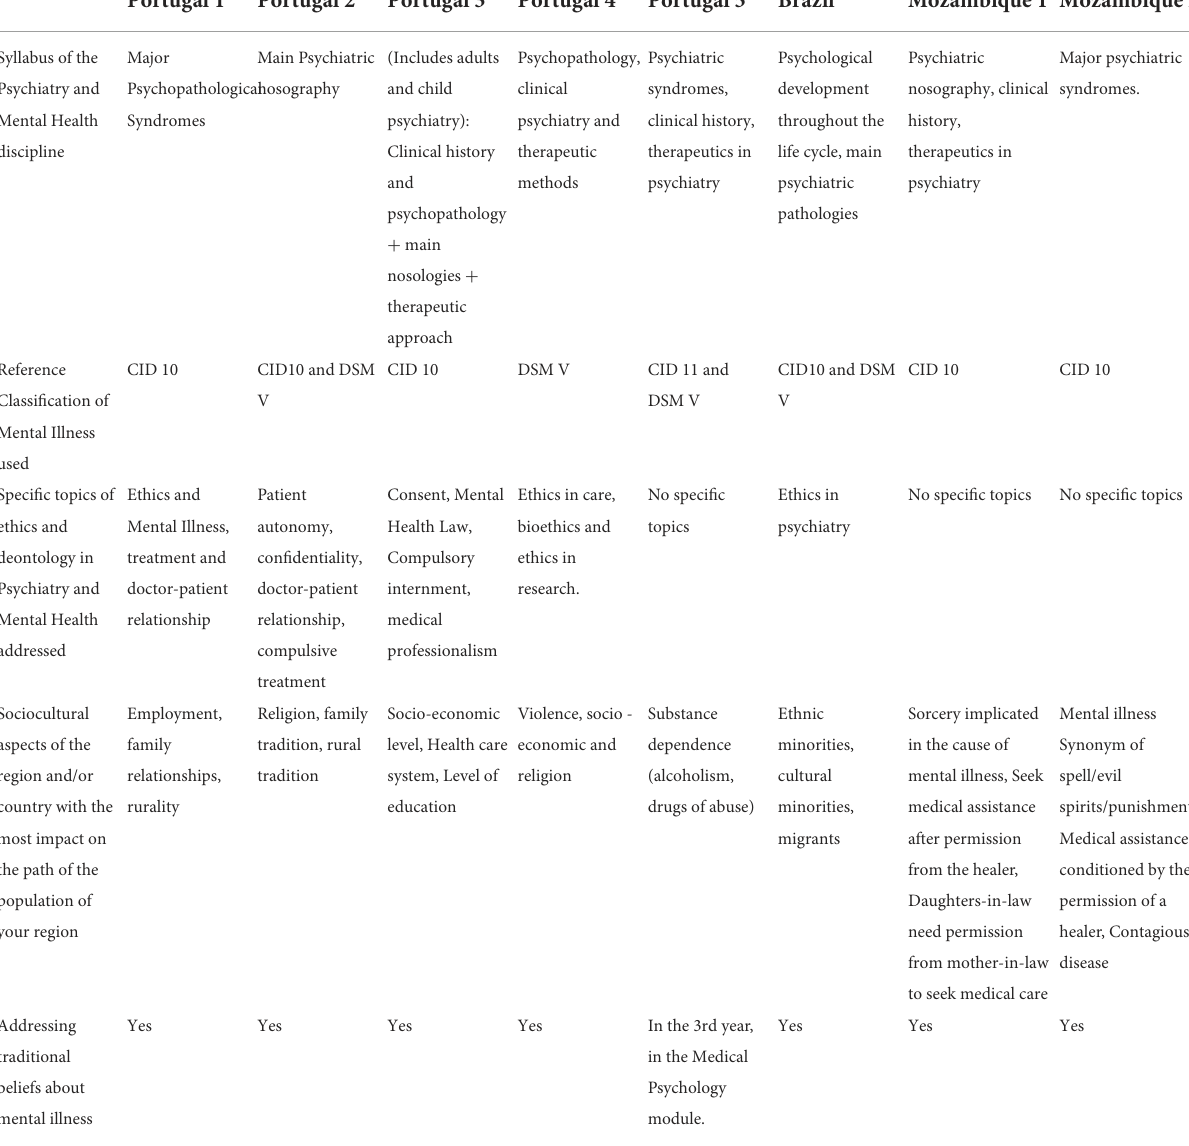
TABLE 3 Delivery of psychiatry